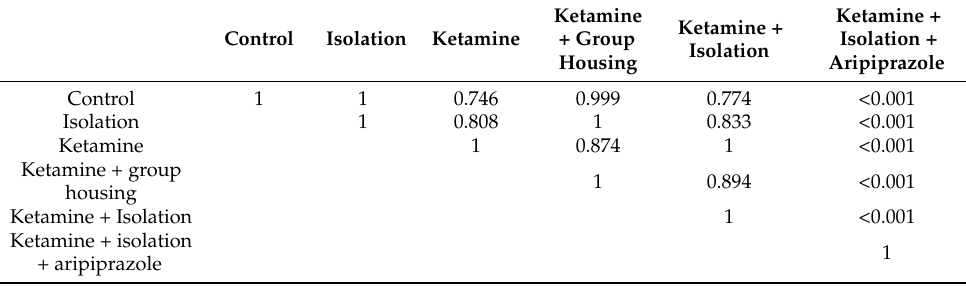
Table 2. All p -values for the time spent in open arms in the elevated plus maze.